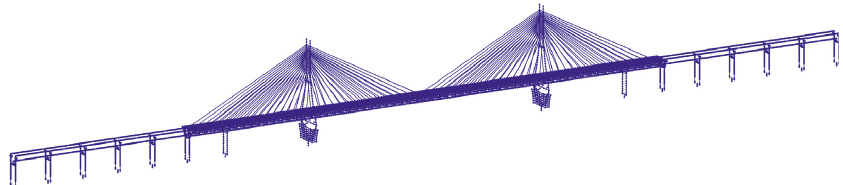
Figure 5: Finite element model of Niutianyang Bridge by software MIDAS CIVIL.